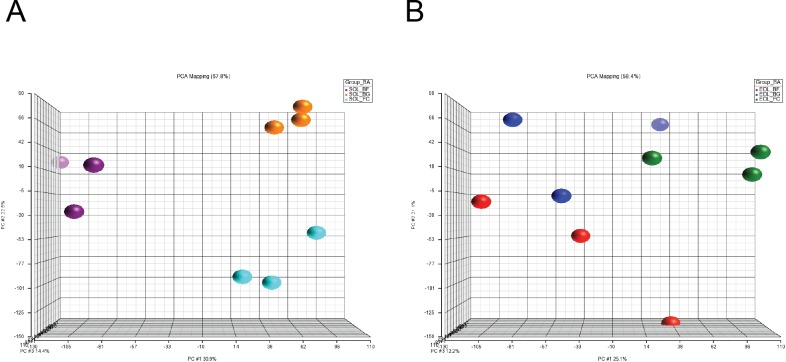
Principal Component Analysis (PCA) of gene expression data in soleus and EDL.PCA analysis of gene expression data in soleus (A) and EDL (B) highlights the high sensitivity of soleus to microgravity exposure compared to EDL.